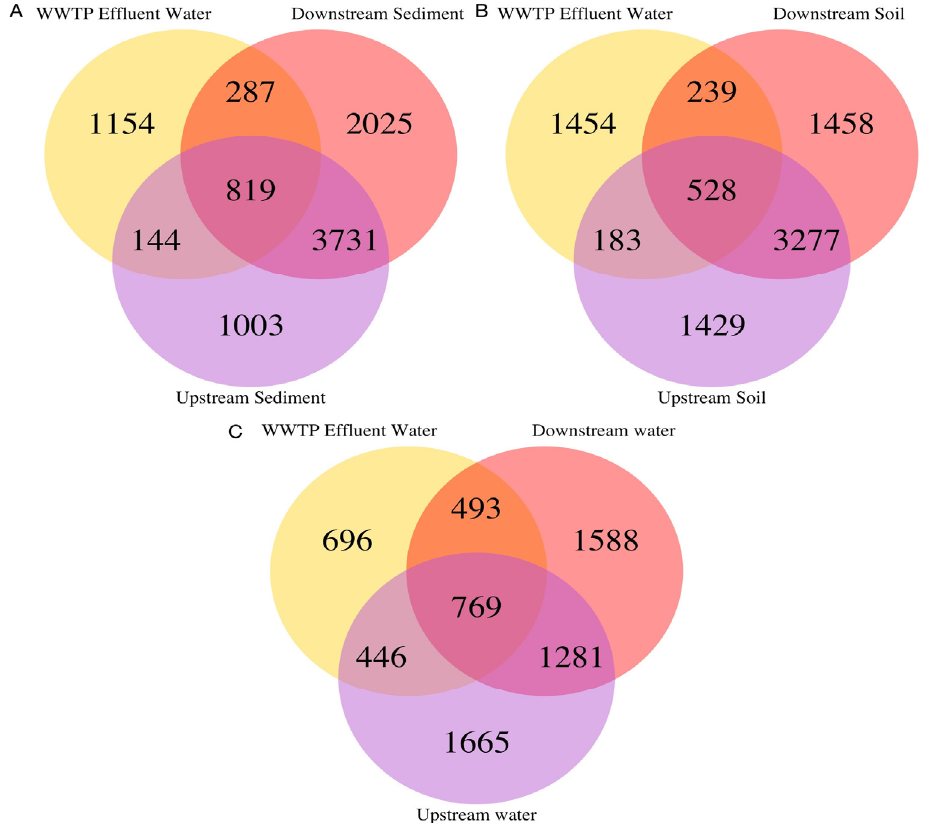
Figure 6. Comparison of unique ASVs in wastewater outflow against ( A ) upstream and downstream sediment samples, ( B ) upstream and downstream soil samples, and ( C ) upstream and downstream water samples.